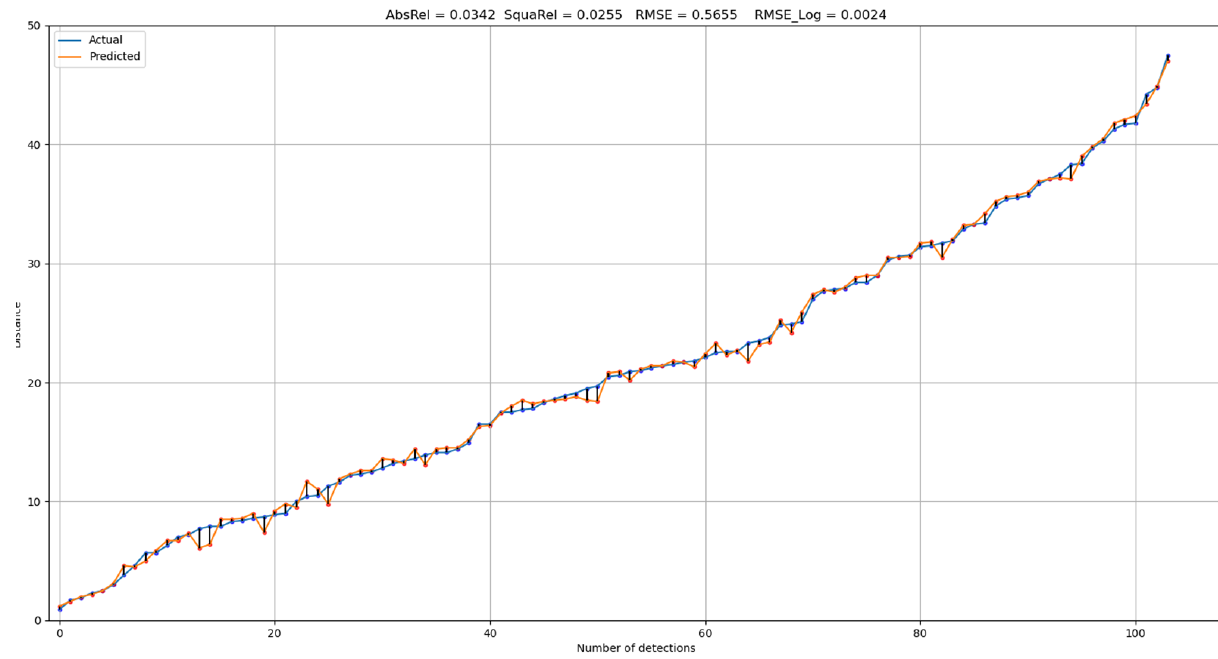
Figure 6. Distance estimation results of the difference between “actual” and “predicted” for all detections.